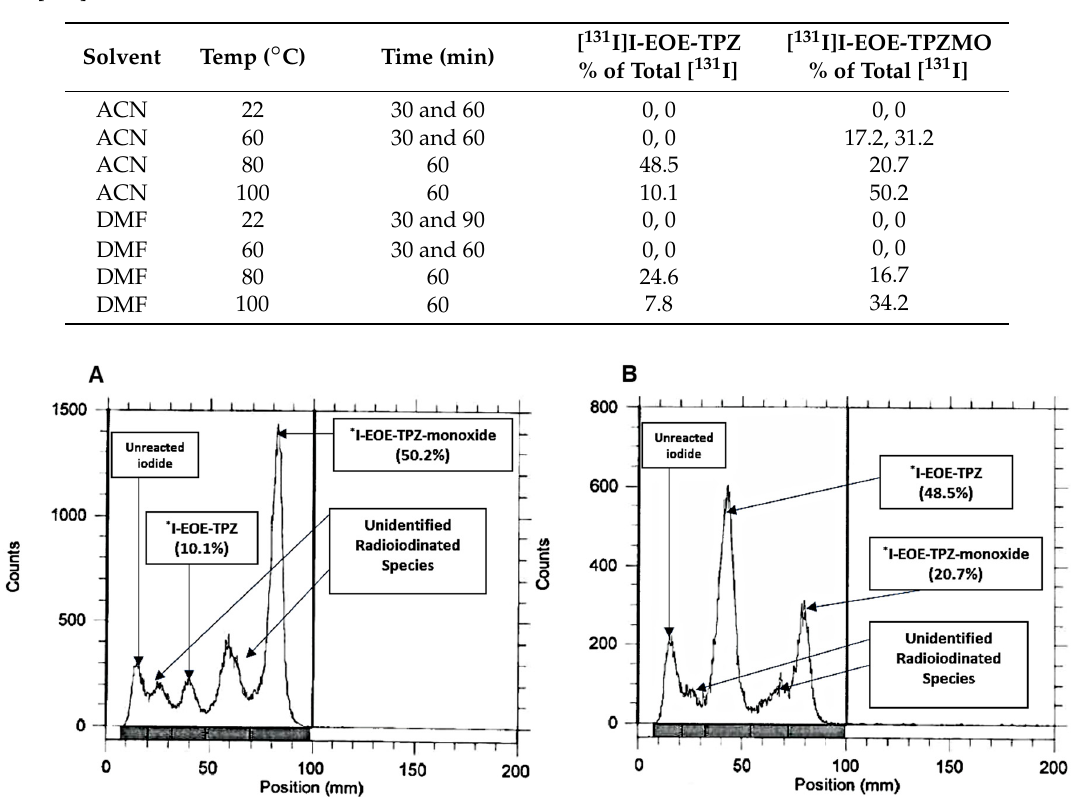
Table 1. Radioiodination of precursor Tos-EOE-TPZ ( P1) via nucleophilic substitution of tosyl by [ 131 I]iodide.